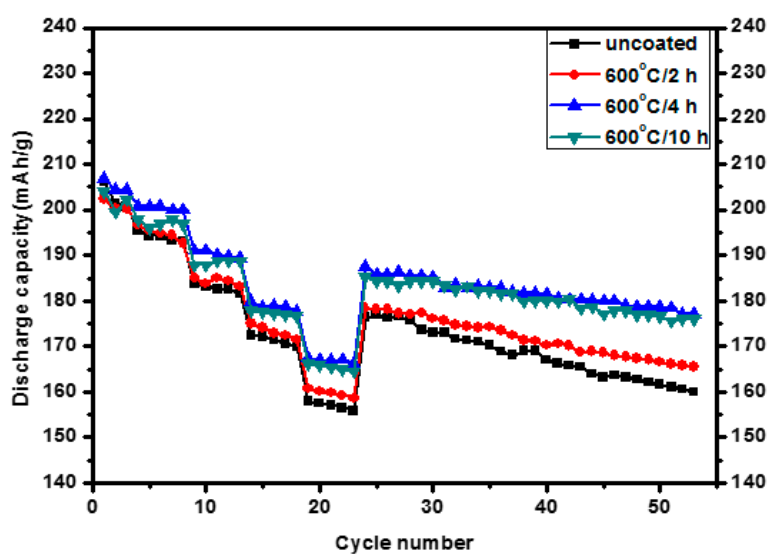
Figure 7. Electrochemical performance of the uncoated and 0.08 wt % Al 2 O 3 -coated Li(Ni 0.6 Co 0.2 Mn 0.2 )O 2 samples annealed at 600 °C for different holding times and cycled between 3.0 and 4.5 V at various C rates.